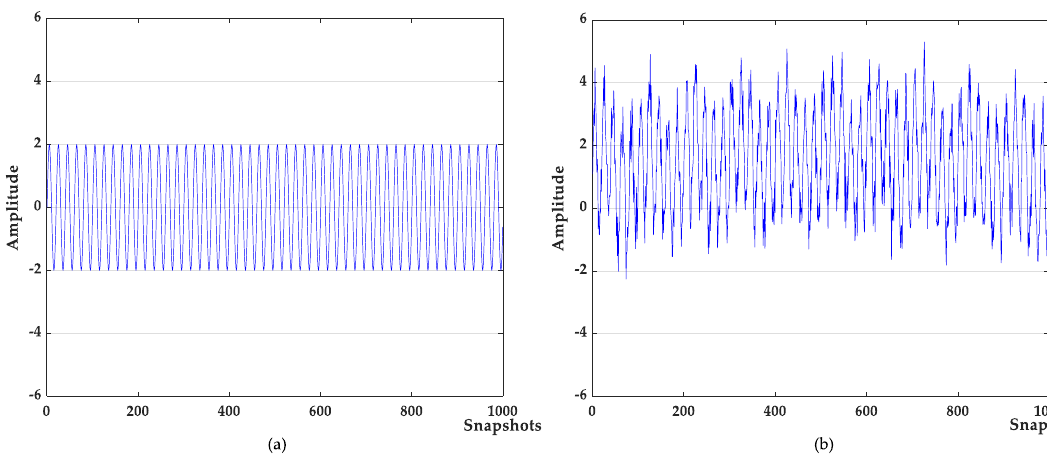
Figure 3. ( a ) target signal; ( b ) simulation signal.